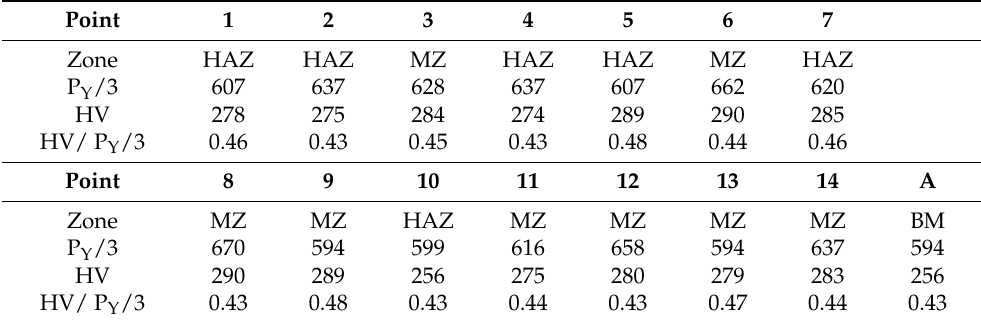
Table 4. Micro-hardness HV and P Y /3 values determined by means of FIMEC tests in the positions shown in Figure 11. The HV/P Y /3 ratio is also shown.